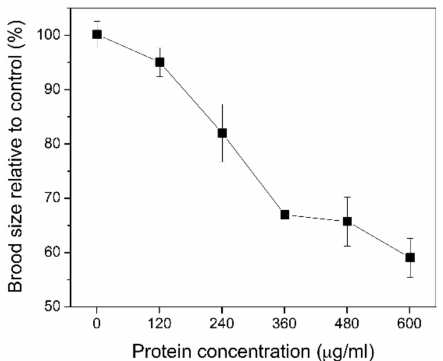
Figure 5. Brood size assay of C. elegans using different concentrations of the purified YqfO03. The assay was measured in 3 d. Error bars represent the standard deviations from the mean of three independent experiments.